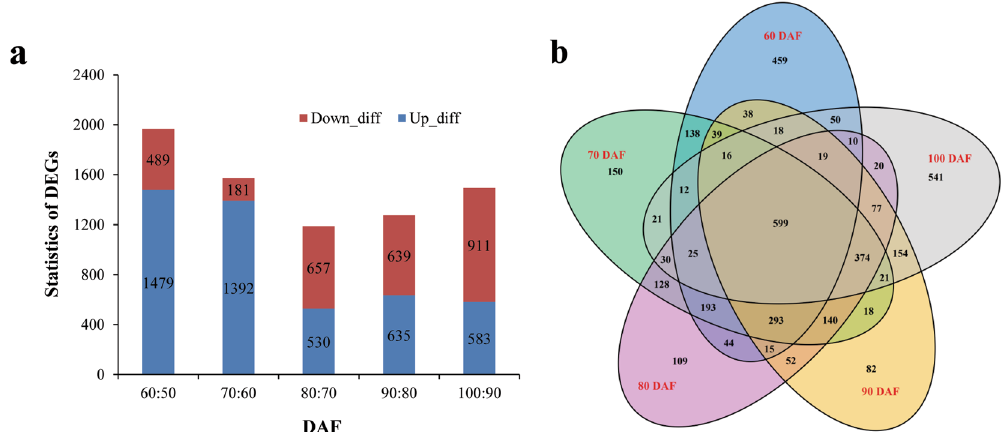
Figure 4. Number and distribution of differentially expressed genes in developing CCSK. ( a ) Numbers of upregulated and downregulated transcripts. ( b ) Numbers of differentially expressed